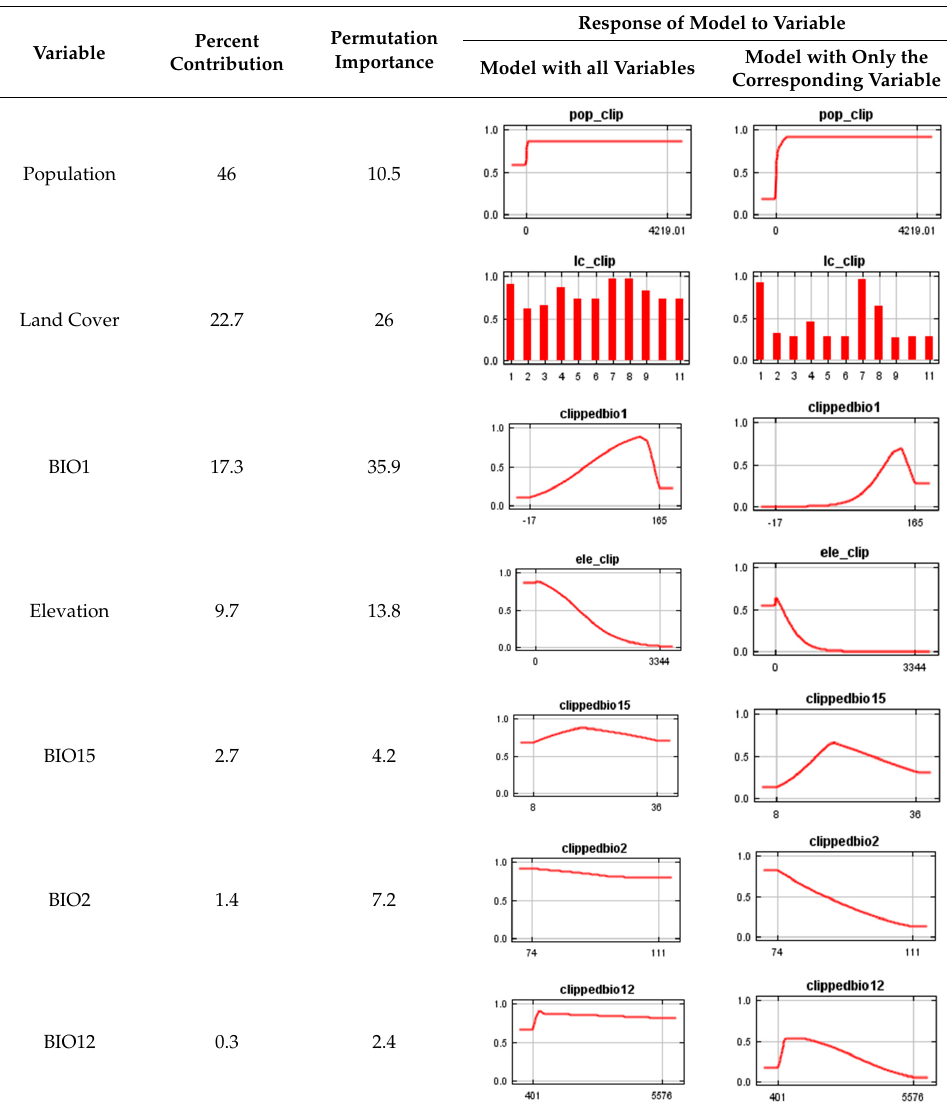
Table 3. Results of the jackknife of variable contributions and model response to the